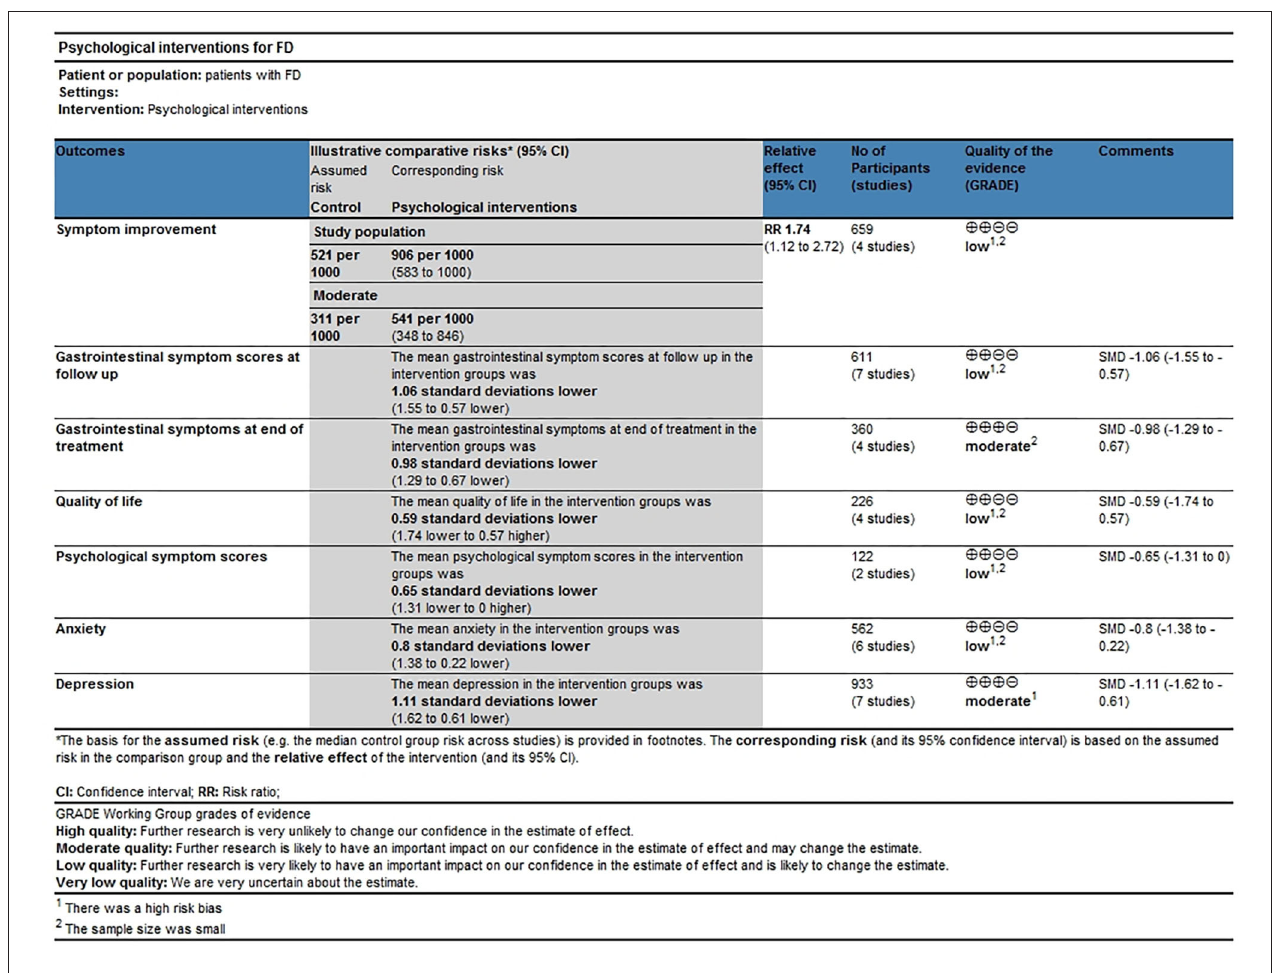
FIGURE 2 | The GRADE quality assessment. FD, functional dyspepsia; SMDs, Standardized mean differences; RRs, risk ratios; CI, confidence